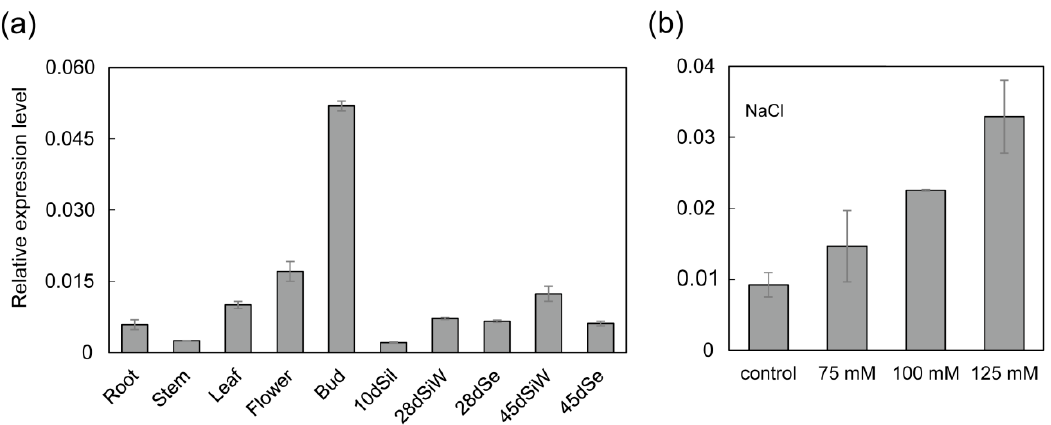
Figure 1. BnWIN1 is expressed in various tissues and is induced by salt stress in Brassica napus . ( a ) The expression pattern of BnWIN1 in B. napus detected by qRT-PCR normalized to BnActin . Total RNA was extracted from various tissues of B. napus . Values are means ± SD ( n = 3 separated samples). Bud, flower bud; 10dSil, silique at 10 days after flowering; 28dSiW and 45dSiW, silique wall at 28 and 45 days after flowering, respectively; 28dSe and 45dSe, seed at 28 and 45 days after flowering, respectively. ( b ) The transcript level of BnWIN1 was induced by NaCl stress in B. napus. Total RNA was extracted from 21-day-old plants treated with 0 (control), 75, 100, and 125 mM NaCl for two weeks. Actin was used as an internal standard. Values are mean ± SD ( n = 3 separate samples).